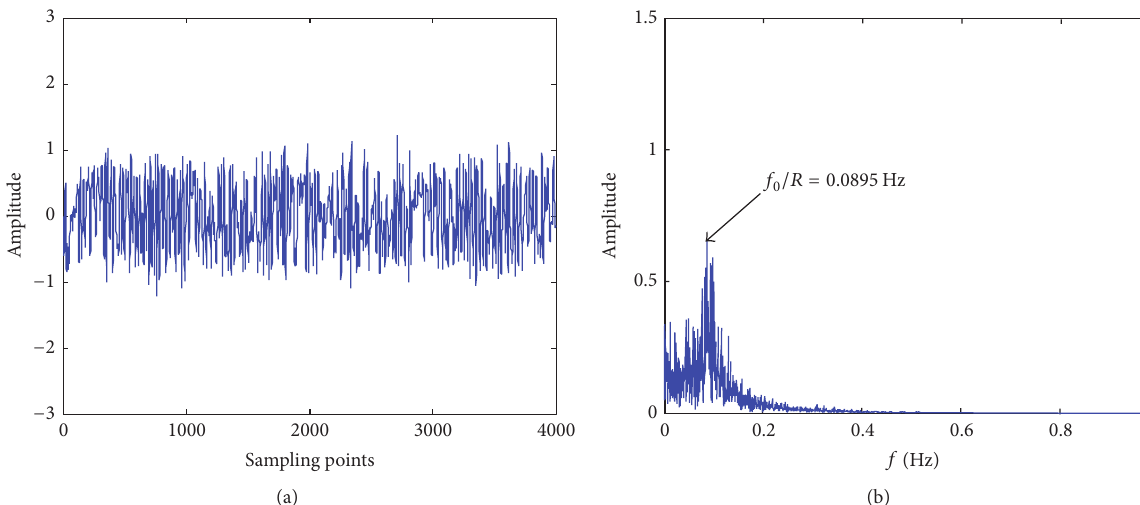
Figure16:FaultdiagnosisresultwiththetraditionalDuffingoscillatorSRmethodinthemildwearoffloatingtile.(a)Time-domainwaveform ofoutputsignals;(b)frequencyspectrumofoutputsignals.Thesystemparametersaresetto 𝜀 = 1/10 , 𝑅 = 100 , 𝑎 = 0.45 , 𝑏 = 2.5 ,and 𝑘 = 0.35 .